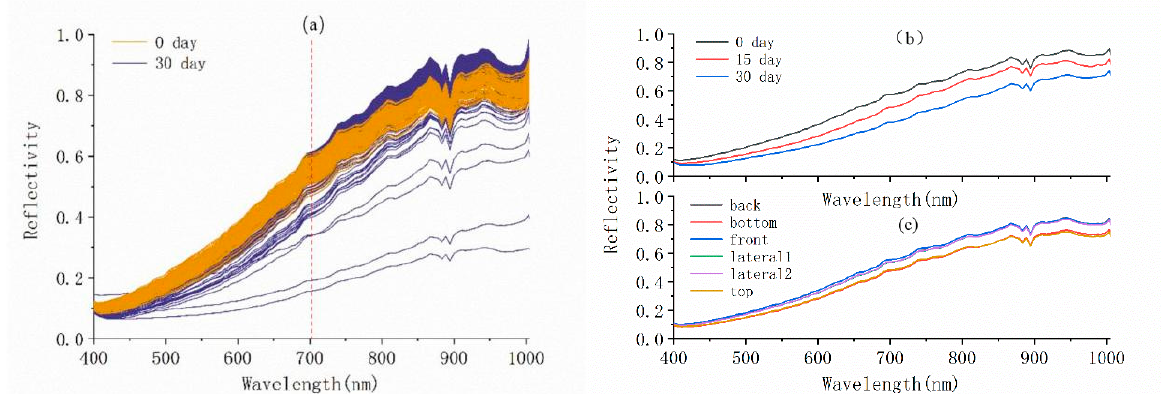
Figure 9. ( a ) Original spectral curves on day 0 and day 30 for all samples; ( b ) Original spectral curves